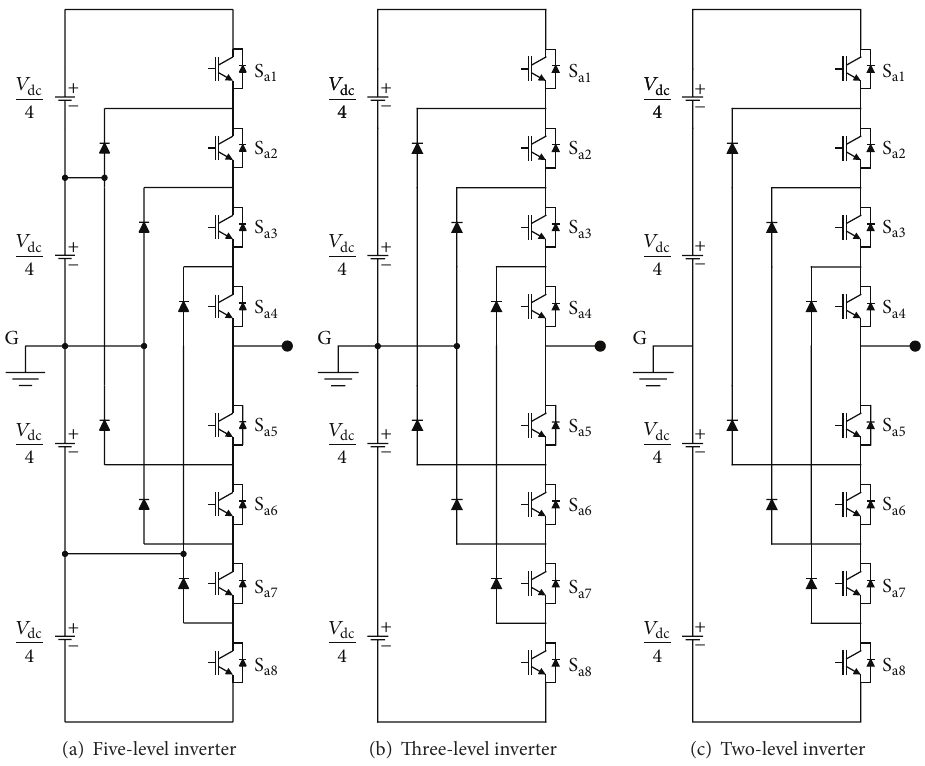
Figure 2: Various inverter